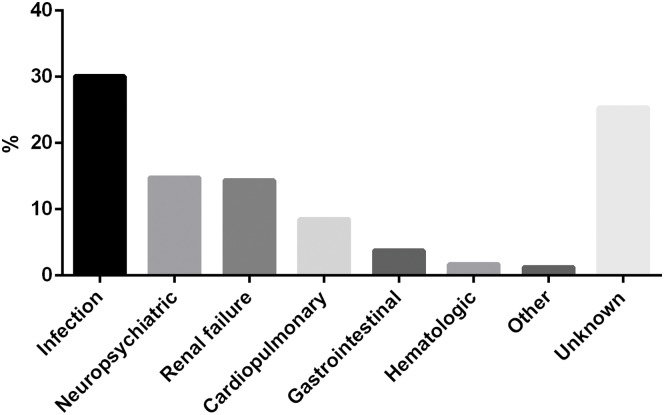
Causes of death among the 236 deceased patients.The most often seen cause of death was infection (30.1%), followed by neuropsychiatric impairments (14.8%), renal failure (14.4%) and cardiopulmonary involvements (8.5%). Ill-defined causes of death, classified as unknown here, represented 25.4% of the total deaths.